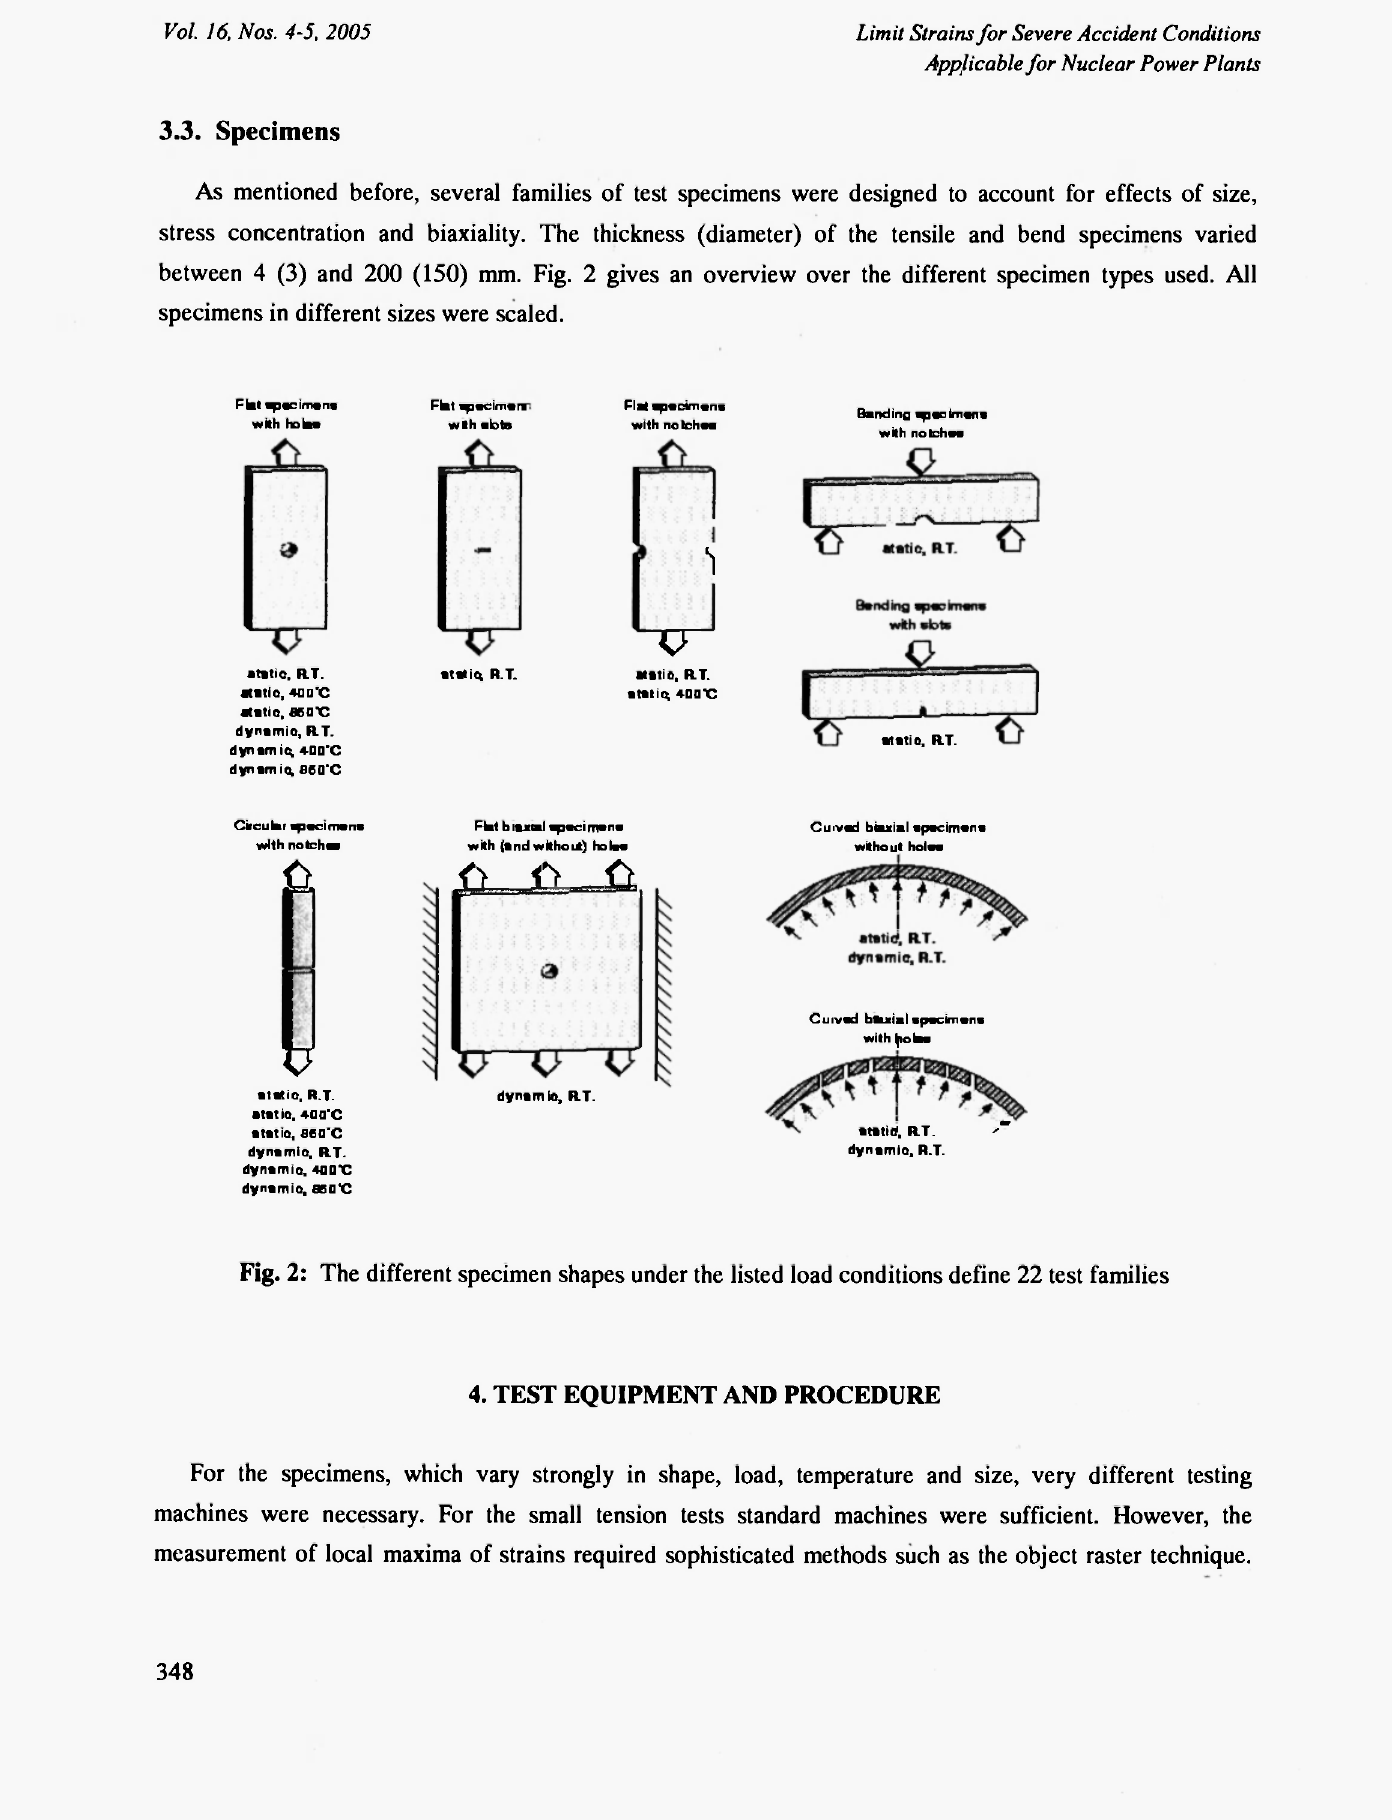
Fig. 2: The different specimen shapes under the listed load conditions define 22 test